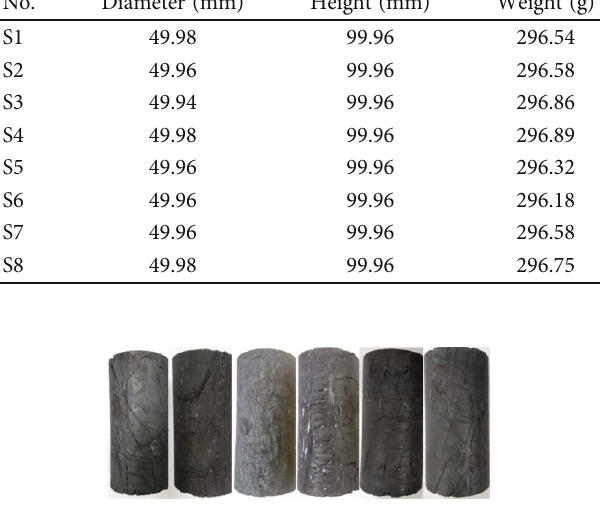
Figure 1: Standard raw coal